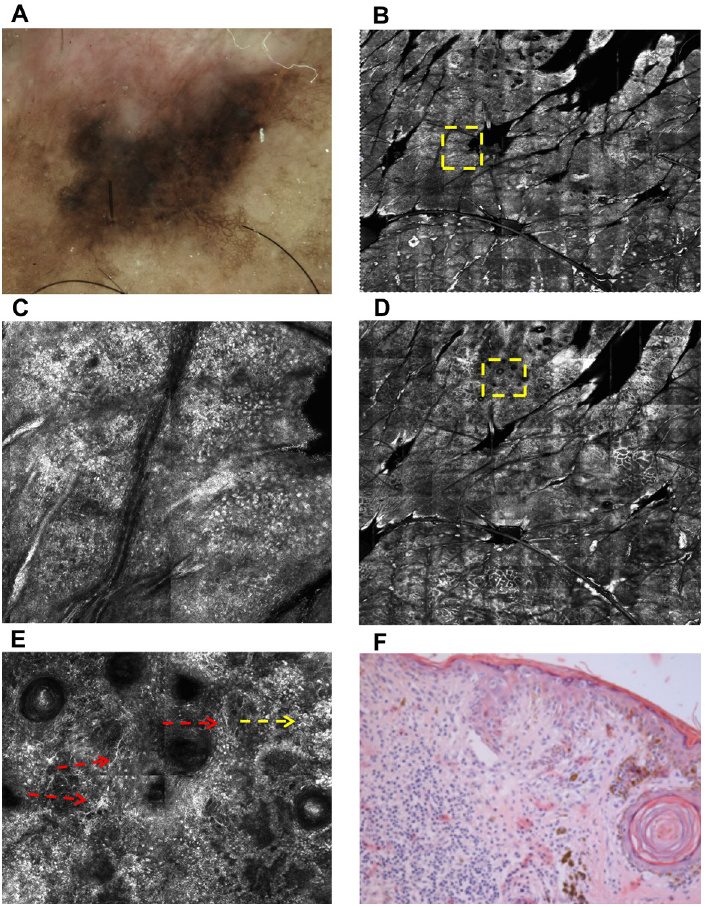
x 1.0 mm square area is marked with yellow dashed outline and better shown in C). (C): Atypical cobblestone pattern. (D): RCM mosaic image (8.0 X 8.0 mm) at DEJ; visual inspection positioned the hotspot at a peripheral location (1.0 x 1.0 mm square area is marked with yellow dashed outline and better shown in E). (E): Non-edged papillae, roundish cells at DEJ (yellow arrow) and dendritic cells (red arrows). (F): Histopathology confirms a superficial spreading melanoma (H&E, original magnification x200), with Breslow = 0.55 and presence of pagetoid